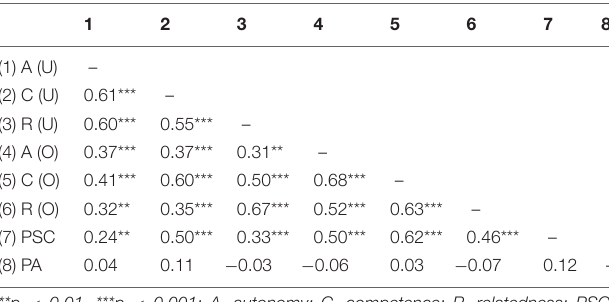
TABLE 6 | Correlation analysis between the